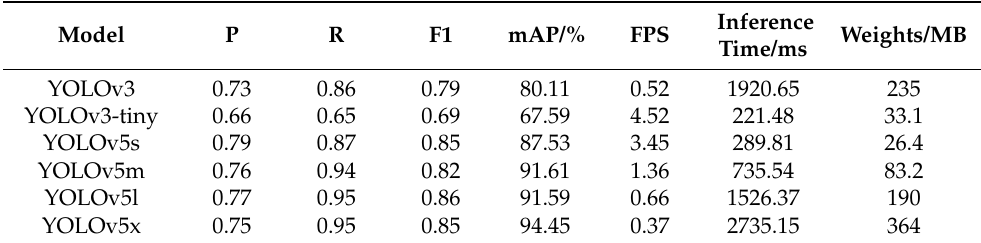
Table 6. Training results of these six models of YOLO series. Model